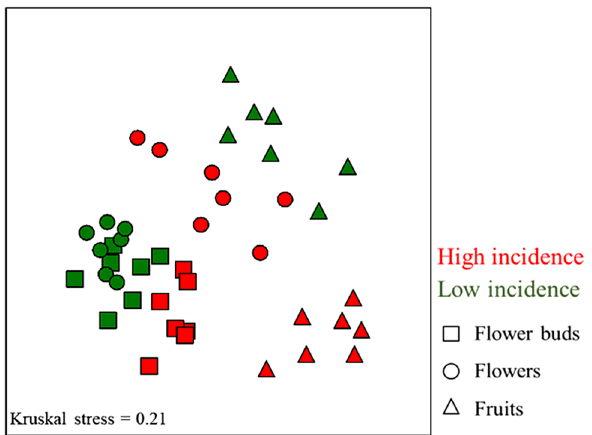
Figure 3. Non-metric multidimensional scale (NMDS) plots for the endophytic fungal assemblages in olive tree due to different olive orchards (with high or low incidence of olive anthracnose) and organ (flower buds, flowers and fruits). Cluster analysis was performed with Bray–Curtis coefficient (raw abundance data). Kruskal’s stress values are presented (values less than 0.2 represent good ordination